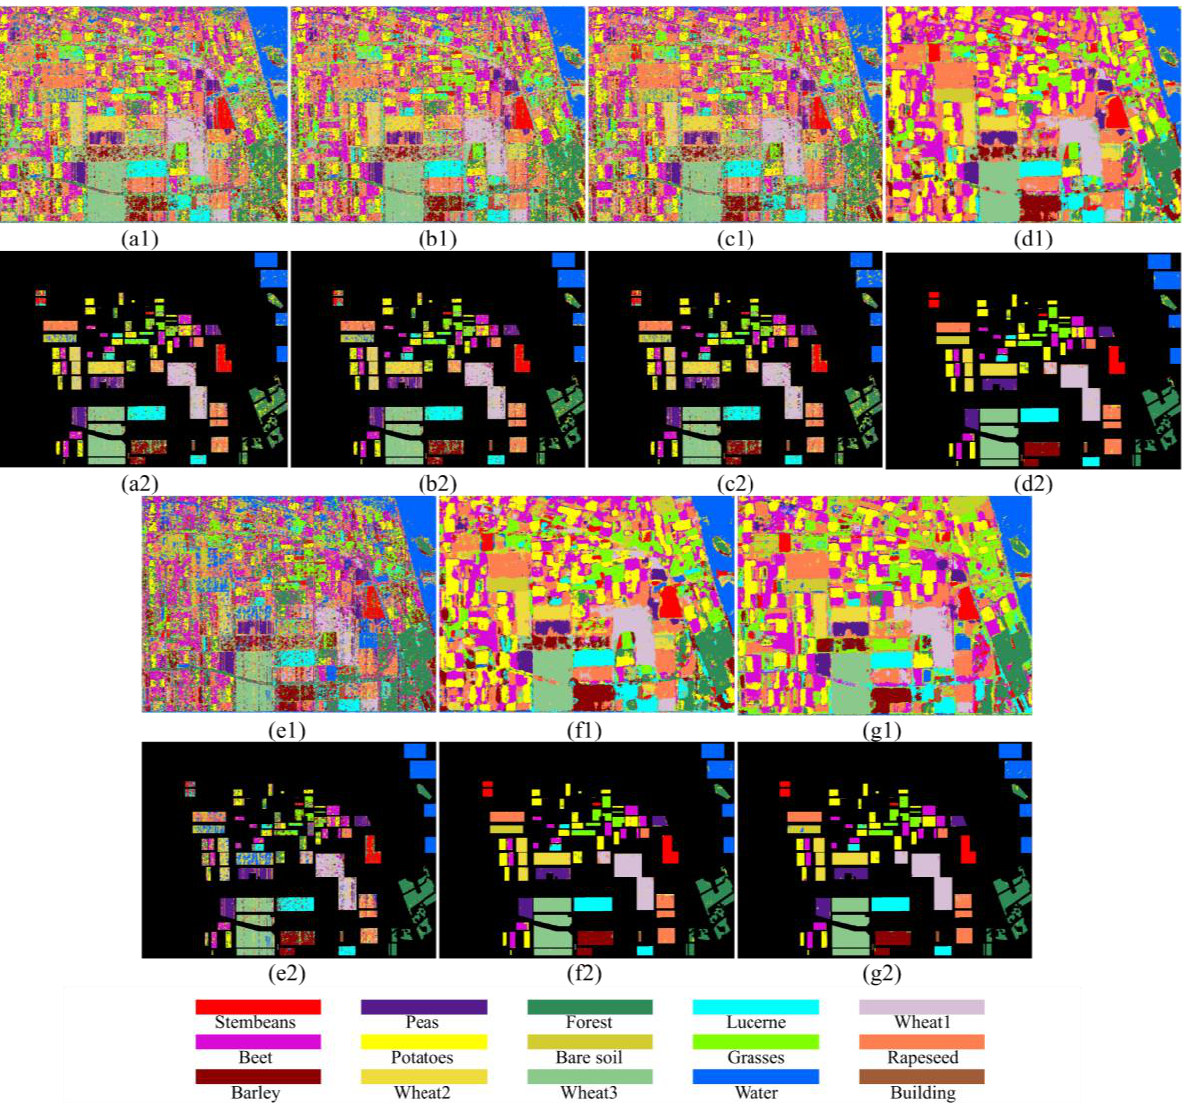
Figure 9. AIRSAR Flevoland classification maps of ( a1 ) SVM, ( b1 ) RF, ( c1 ) 1D-CNN, ( d1 ) 2D-CNN, ( e1 ) miniGCN, ( f1 ) FuNet, and ( g1 ) dual-branch FuNet. ( a2 ) – ( g2 ) Masked results according to the ground-truth of ( a1 ) – ( g1 ).